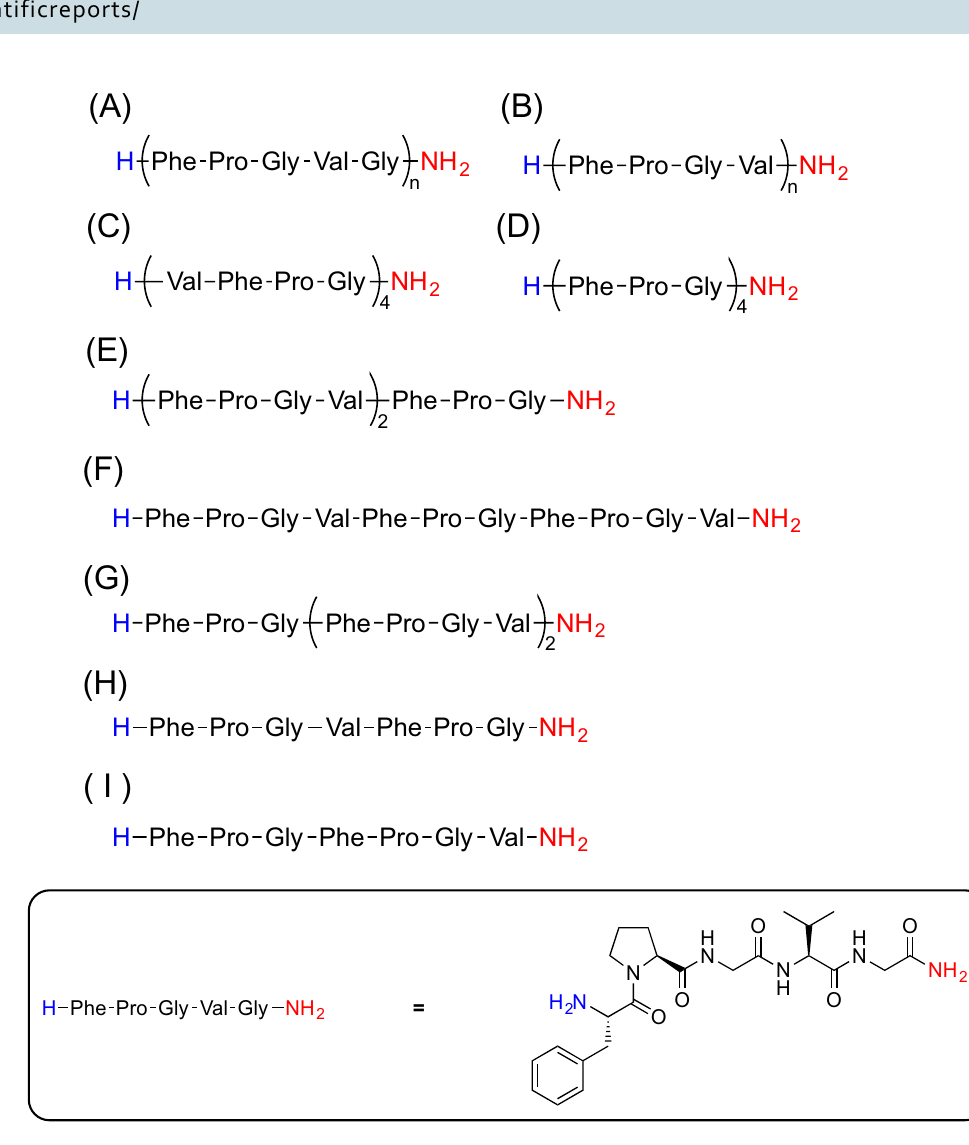
Figure 1. Chemical structures of the elastin-like peptide (ELP) analogues synthesized in this study. The chemical structures of ( A ) (FPGVG) n (n = 4, 5), ( B ) (FPGV) n (n = 2–5), ( C ) (VFPG) 4 , ( D ) (FPG) 4 , ( E )